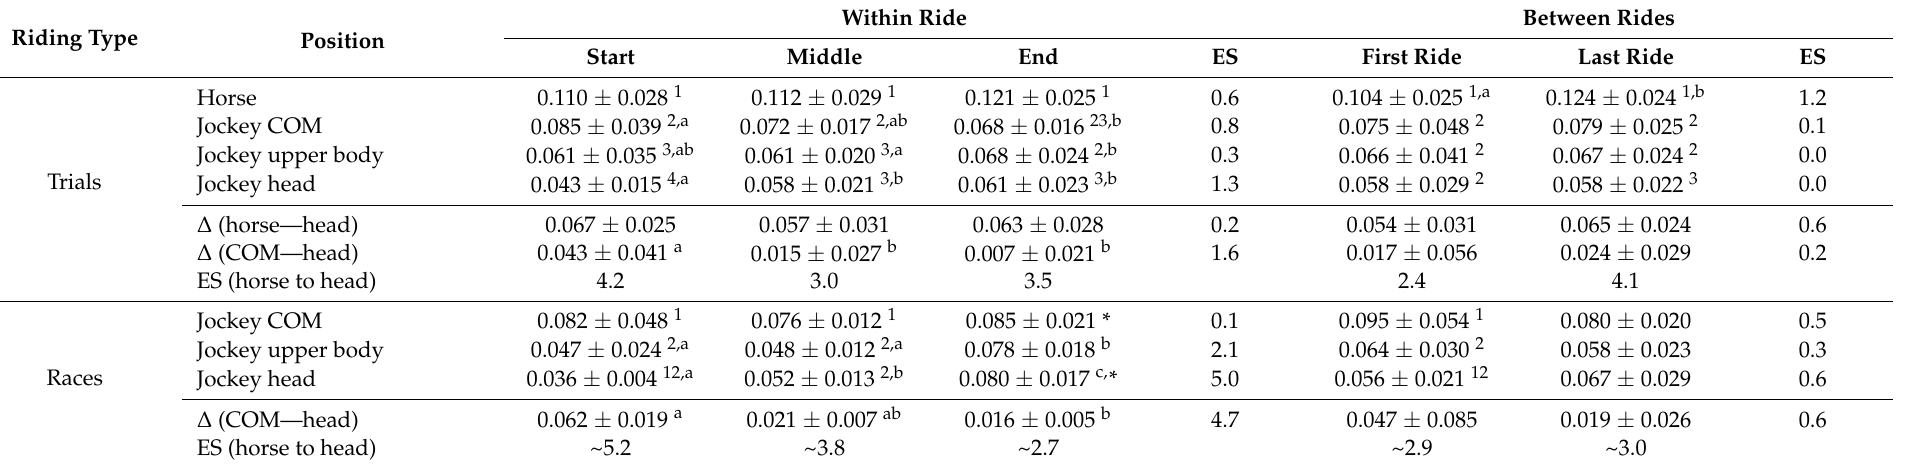
Table 4. Mean ( ± SD) magnitude of displacements (m) of horse and jockey in a trial ( n = 48) or race ( n = 16) and between the first and last ride ( n = 10, trials, n =